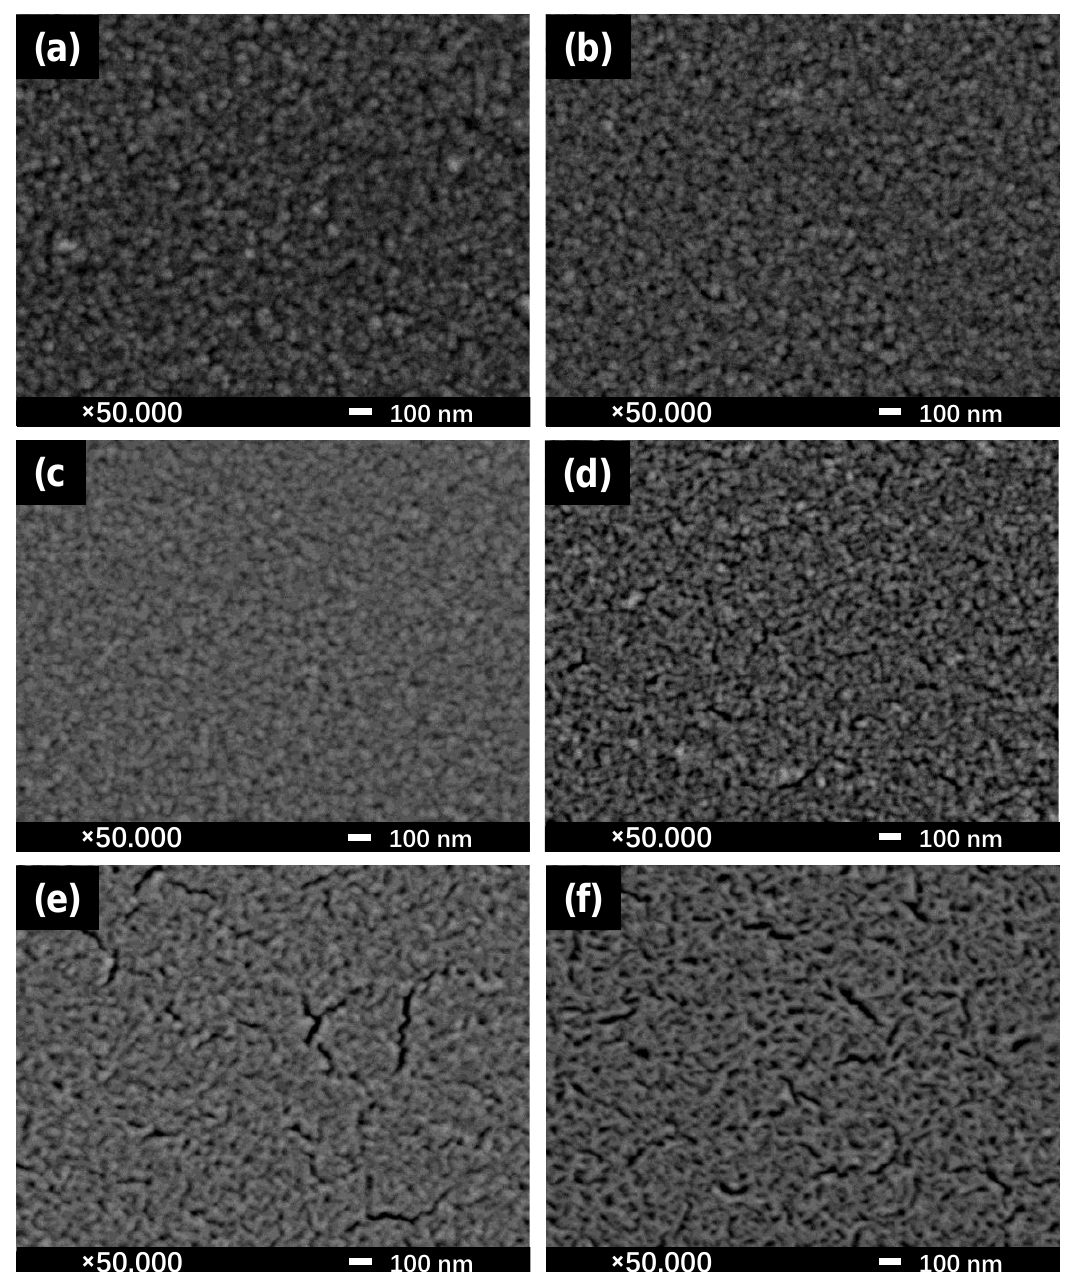
Figure 3. Scanning electron microscope (SEM) observations the top surface of Cu 2 O films deposited with various oxygen ion beam current: ( a ) 0 A, ( b ) 1.3 A, ( c ) 2.0 A, ( d ) 3.0 A, ( e ) 4.0 A, and ( f ) 5.0 A.